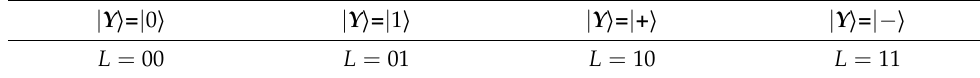
Table 1. Coding rule of generating L .